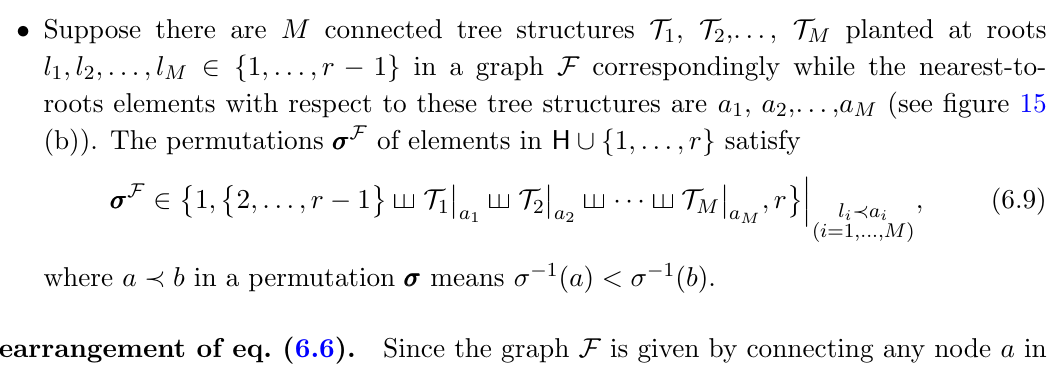
Figure 15 . (a): a typical tree structure with sub-trees planted at the node a , (b): a typical graph with trees planted at roots l 1 ; : : : ; l M 2 f 1 ; : : : ; r (cid:0) 1 g